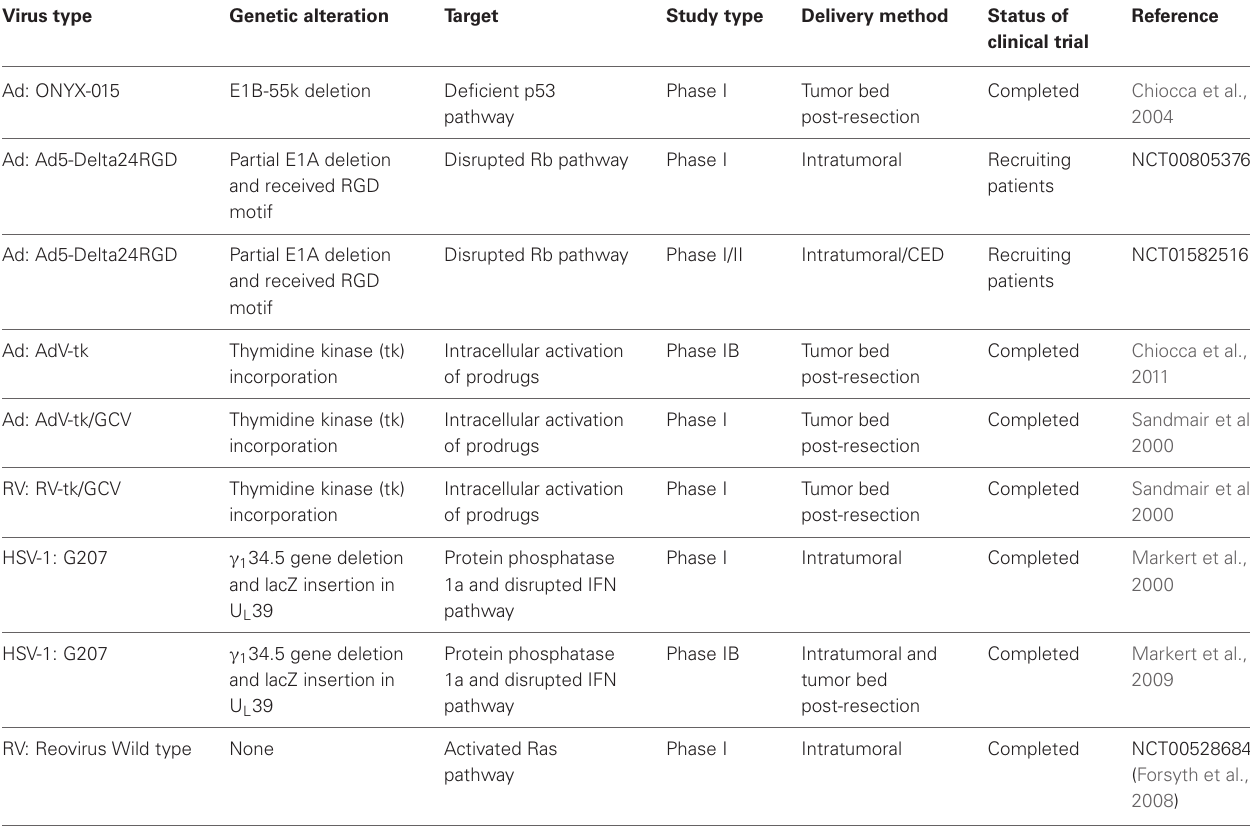
Table 1 | Completed and ongoing clinical trials using oncolytic virotherapy as a therapeutic strategy against malignant glioma. Virus